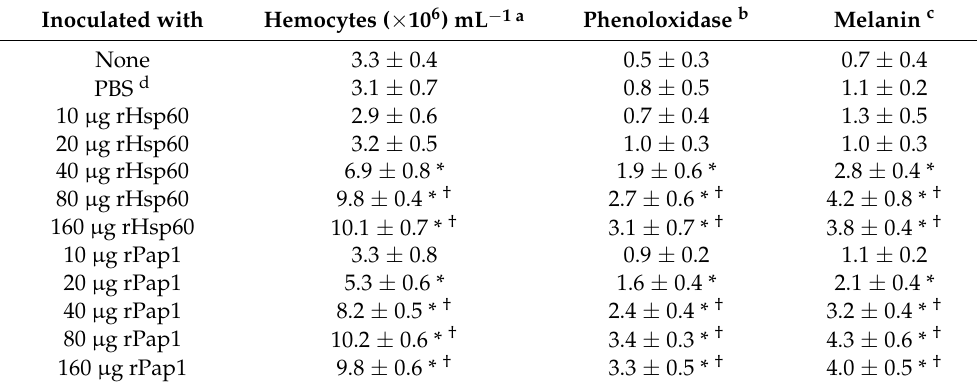
Table 2. Hemocyte count, phenoloxidase, and melanin production in Galleria mellonella larvae inoculated with either recombinant Hsp60 or